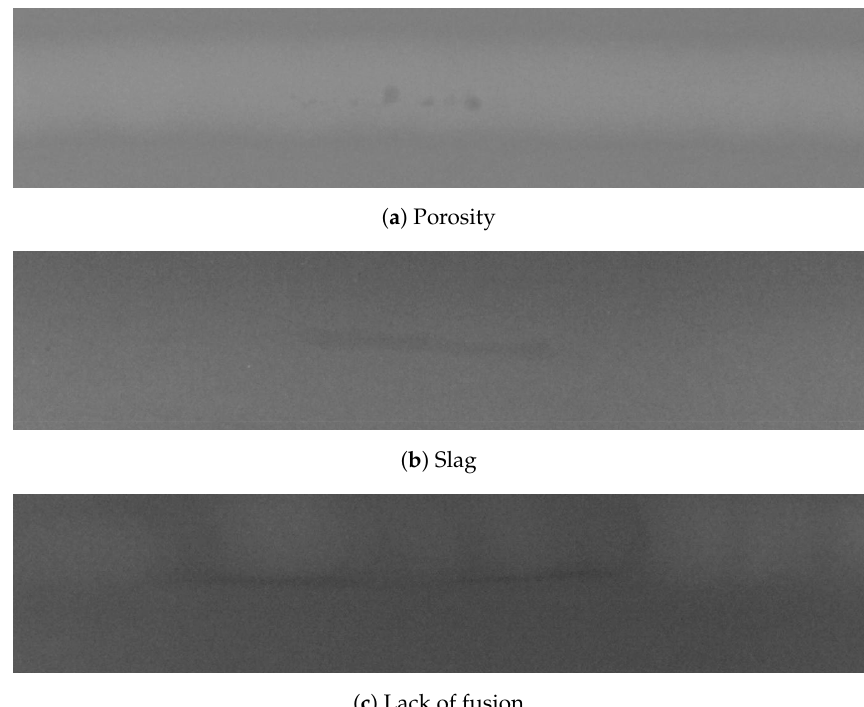
Figure 4. welding defect.